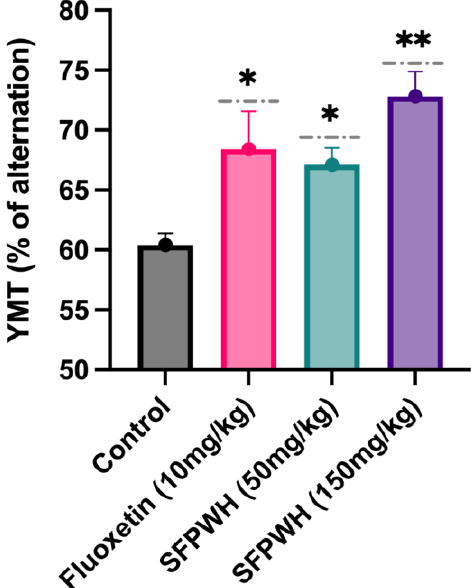
Figure 3. Effect of safflower water extract treatment on spontaneous alternation in YMT. Each mouse was allowed to explore the Y maze in an 8 min session. The number of alternations between 3 arms was calculated and reported as a percentage of the total number of entries. Each bar represents the mean ± SEM (n = 8). * and ** indicates significantly different at p < 0.05 versus untreated group, Student t -test.